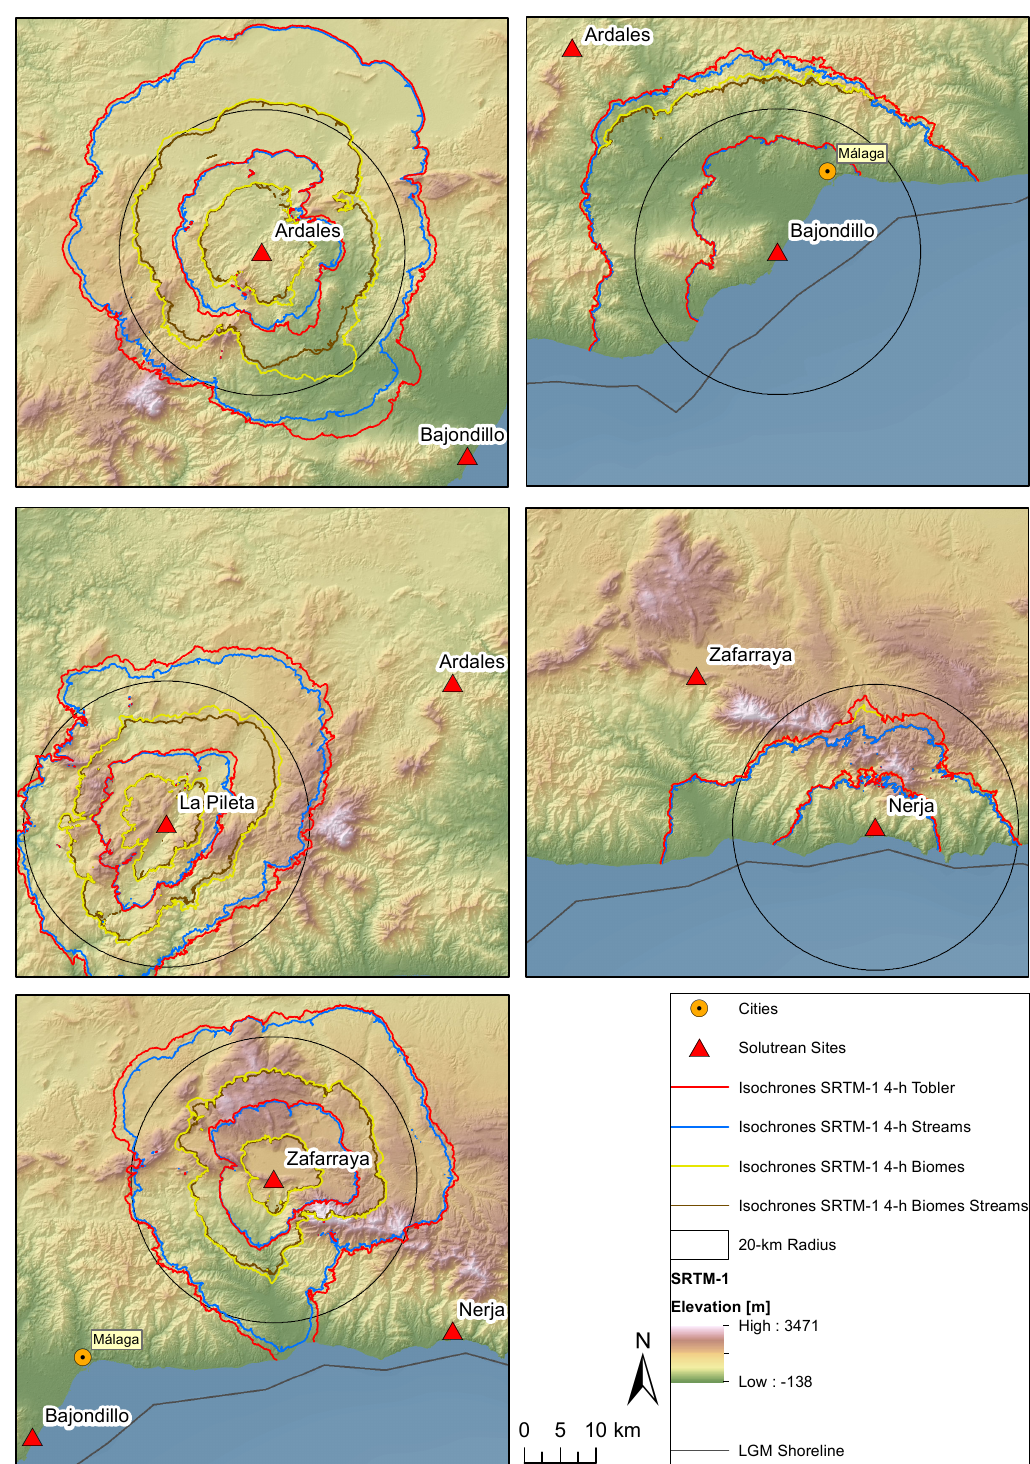
Figure 8. Comparison of the resulting 4- and 8-h isochrones, SRTM-1 DEM. Base map: SRTM-1